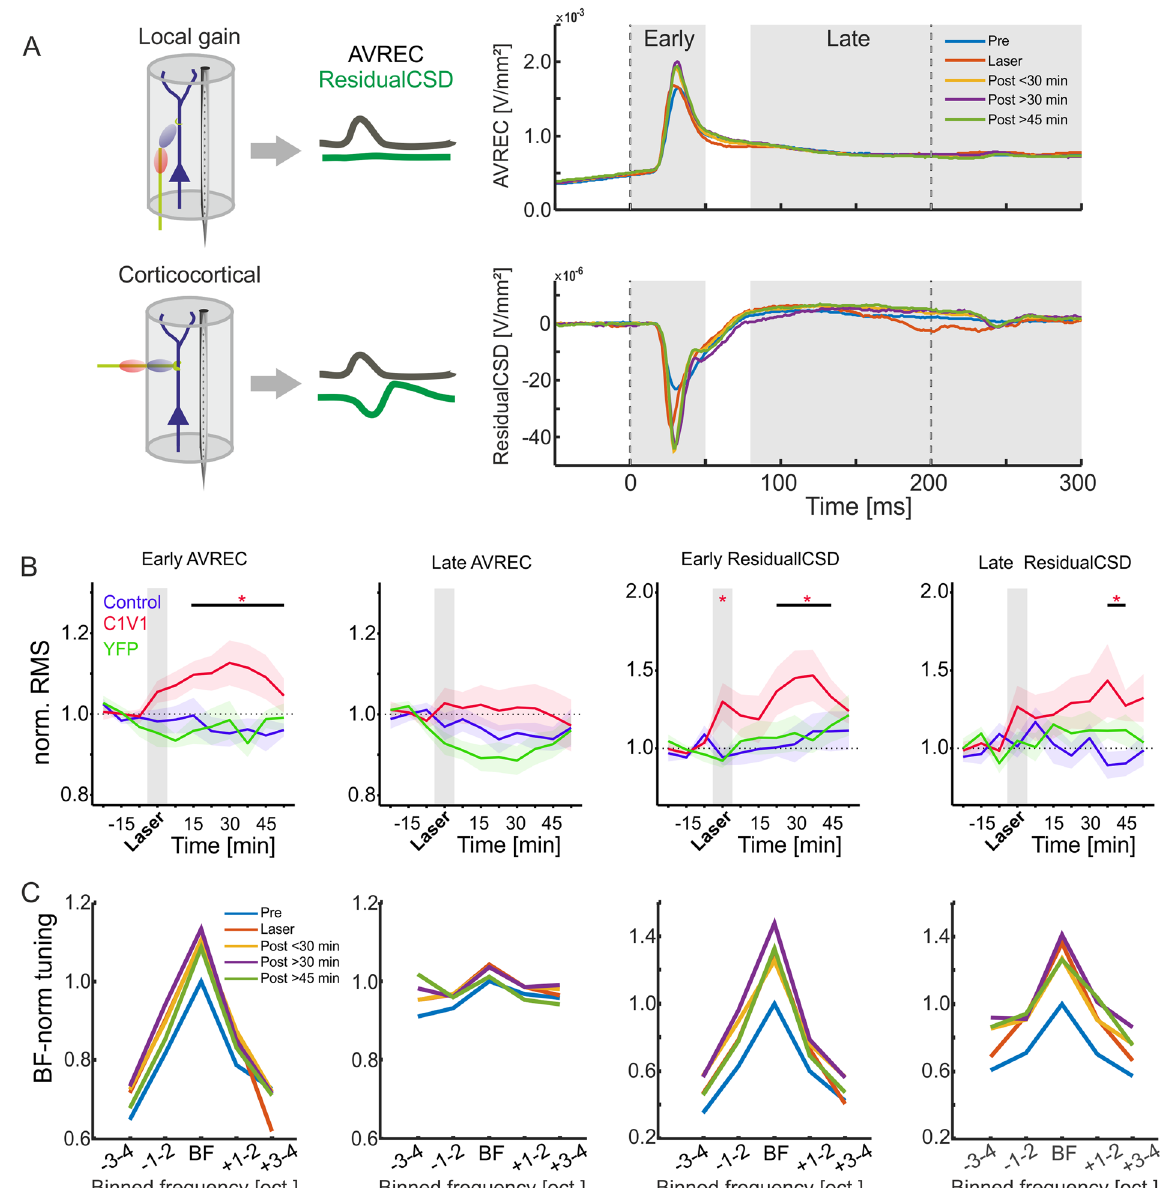
Figure 5. Temporal development of early and late AVREC and ResidualCSD activity ( A ) Grand average traces of the BF-evoked AVREC (top) and ResidualCSD (bottom) of the C1V1 group (n = 12) for binned pre, laser and post ( < 30, > 30 & > 45 min)-measurements. Right, insets illustrate that AVREC activity is mainly associated with local columnar activity, while the ResidualCSD quantifies contributions from lateral corticocortical input (cf Happel et al ., 18,20 ). ( B ) Temporal time courses of Pre-normalized early/late AVREC and early/late ResidualCSD traces of C1V1 (red), control (blue) and YFP (green) groups (n = 12, n = 7, n = 7, respectively) shown for BF stimulation. Early AVREC signal displayed a significant increase in post-measurements for the C1V1 group whereas time courses of the control and YFP groups were stable. Late AVREC signal showed no significant differences between either group. RMS ResidualCSD values of early and late time windows displayed a similar temporal development as the early AVREC becoming significantly increased in the later post- measurements within the C1V1 group. Control and YFP groups showed no significant changes over time. Note the peaking in the early ResidualCSD RMS during laser stimulation, which is only present in the C1V1 group. Asterisks mark significant changes according to the applied mixed linear models of the normalized data towards the control group (see Materials and Methods). ( C ) Tuning curves of the RMS value normalized to BF-evoked responses in the pre-condition for early/late AVREC and early/late ResidualCSD for binned time points for C1V1 group. Note the general increase of the overall tuning curve relative to pre